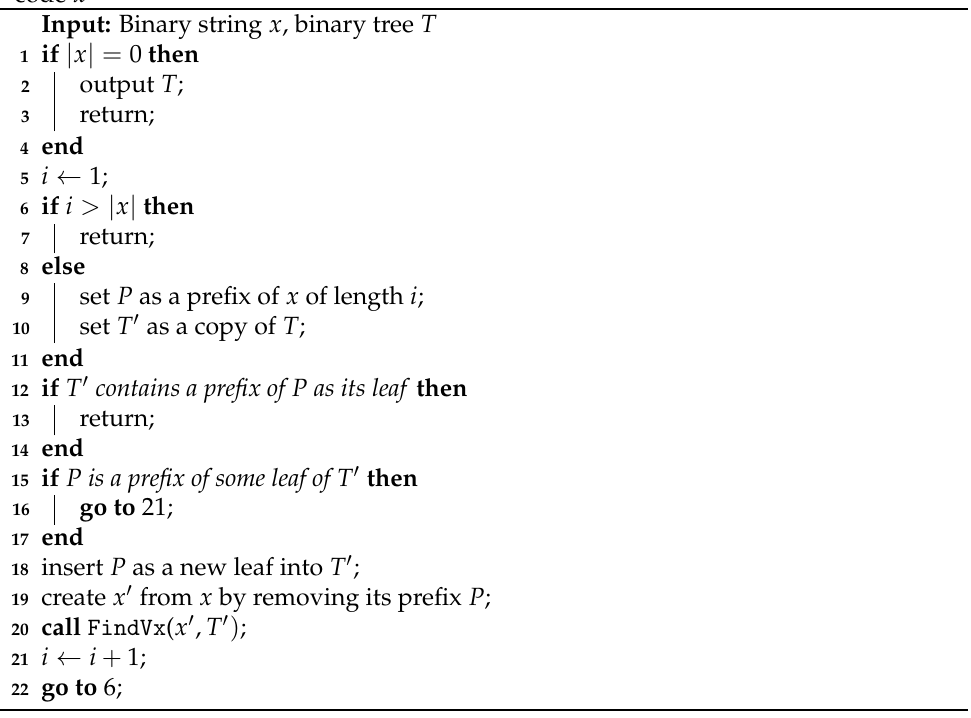
Algorithm 1: Algorithm FindVx( x , T ) for finding all minimal P -codes that de- code